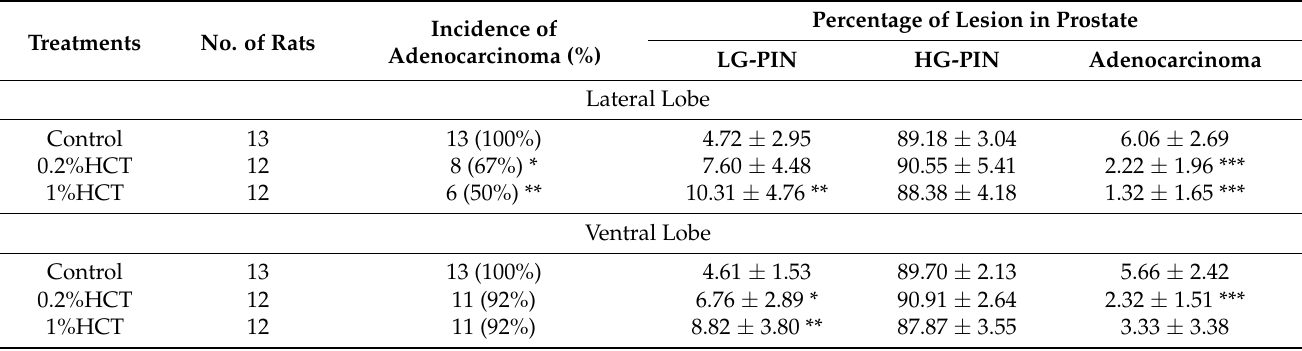
TRAP, Transgenic Rat for Adenocarcinoma of Prostate; HCT, Houttuynia cordata Thunb.; LG, low grade; HG-PIN, high grade prostatic intraepithelial neoplasia. The data are expressed as mean ± SD. * p < 0.05; ** p < 0.01; *** p < 0.001 compared to control group using one-way ANOVA (post hoc: